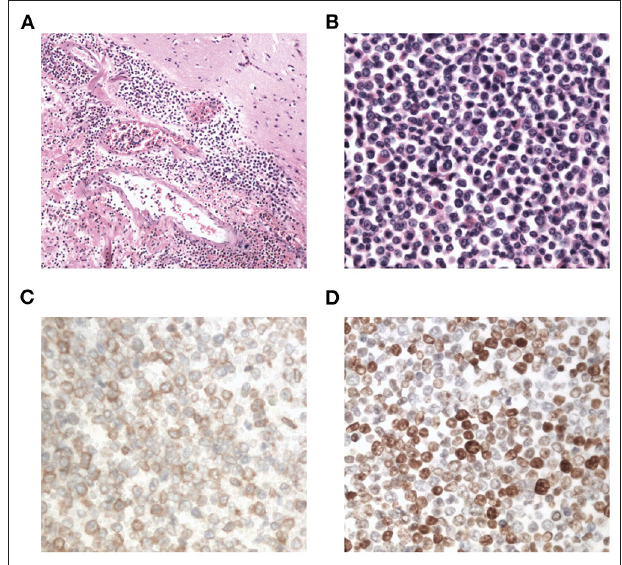
FIGURE 3 | Photomicrographs of the resected brain tissue revealing myeloid cell hyperplasia with hemorrhage (hematoxylin and eosin stain A : × 100, B : × 400), and immunohistochemical staining demonstrating that tumor cells are positive for myeloperoxidase ( C : × 400) and Ki-67( D : ×